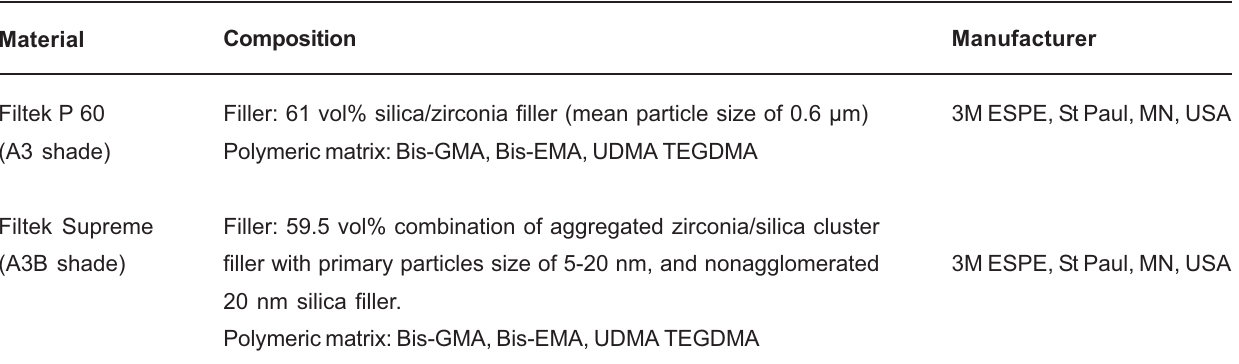
TABLE 1- Composition of the materials used in this Composition